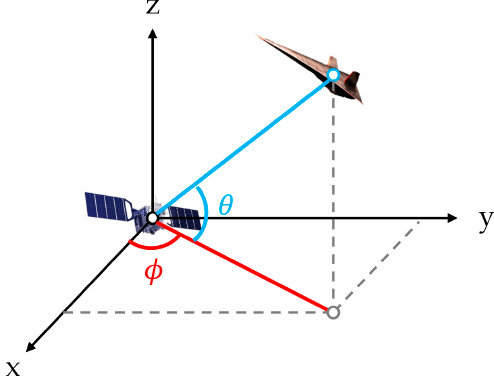
Figure 1. The measurement model of the satellite.